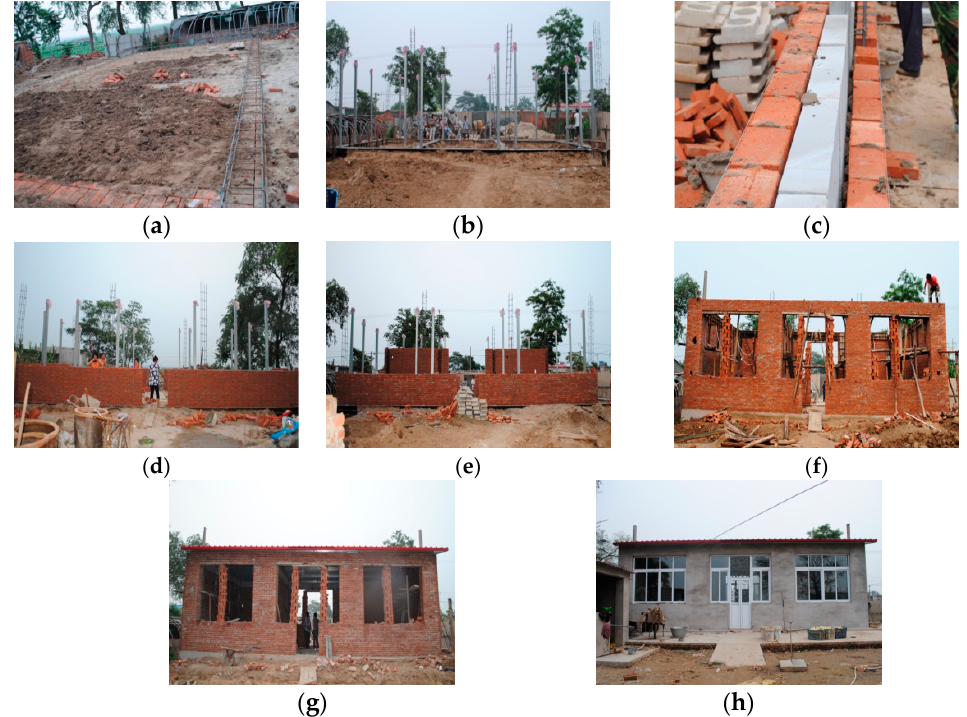
Figure 11. The construction site of the integrated fly ‐ ash masonry structure with an insulated layer and lightweight steel stem embedded: ( a ) groundsill construction; ( b ) construction of lightweight concrete ‐ filled steel stem; ( c ) construction of insulating layer for fly ‐ ash masonry blocks; ( d ) wall construction on the north side; ( e ) wall construction on the south side; ( f ) ring beam construction; ( g ) roofing construction; and ( h ) completion of major structure of rural housing.